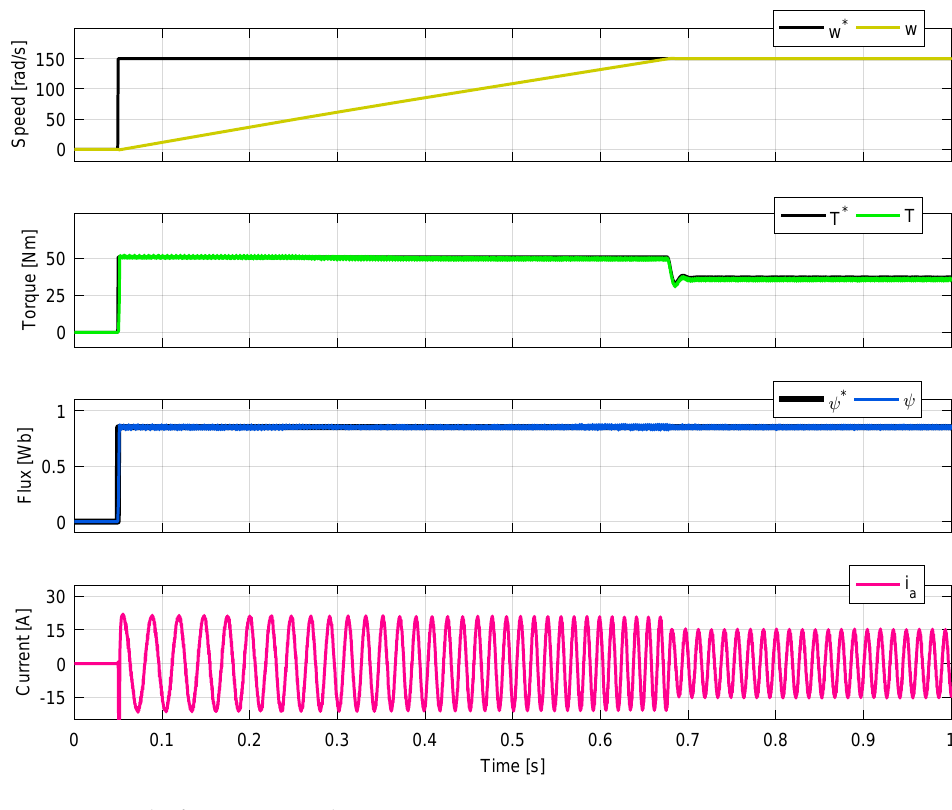
Figure 7. Results for 3L-NPC with N = 4.